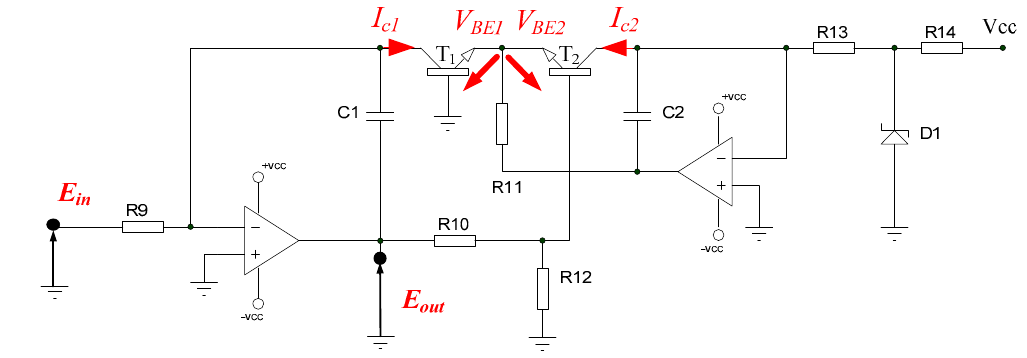
Figure 7. Electrical circuit of the logarithmic amplifier.